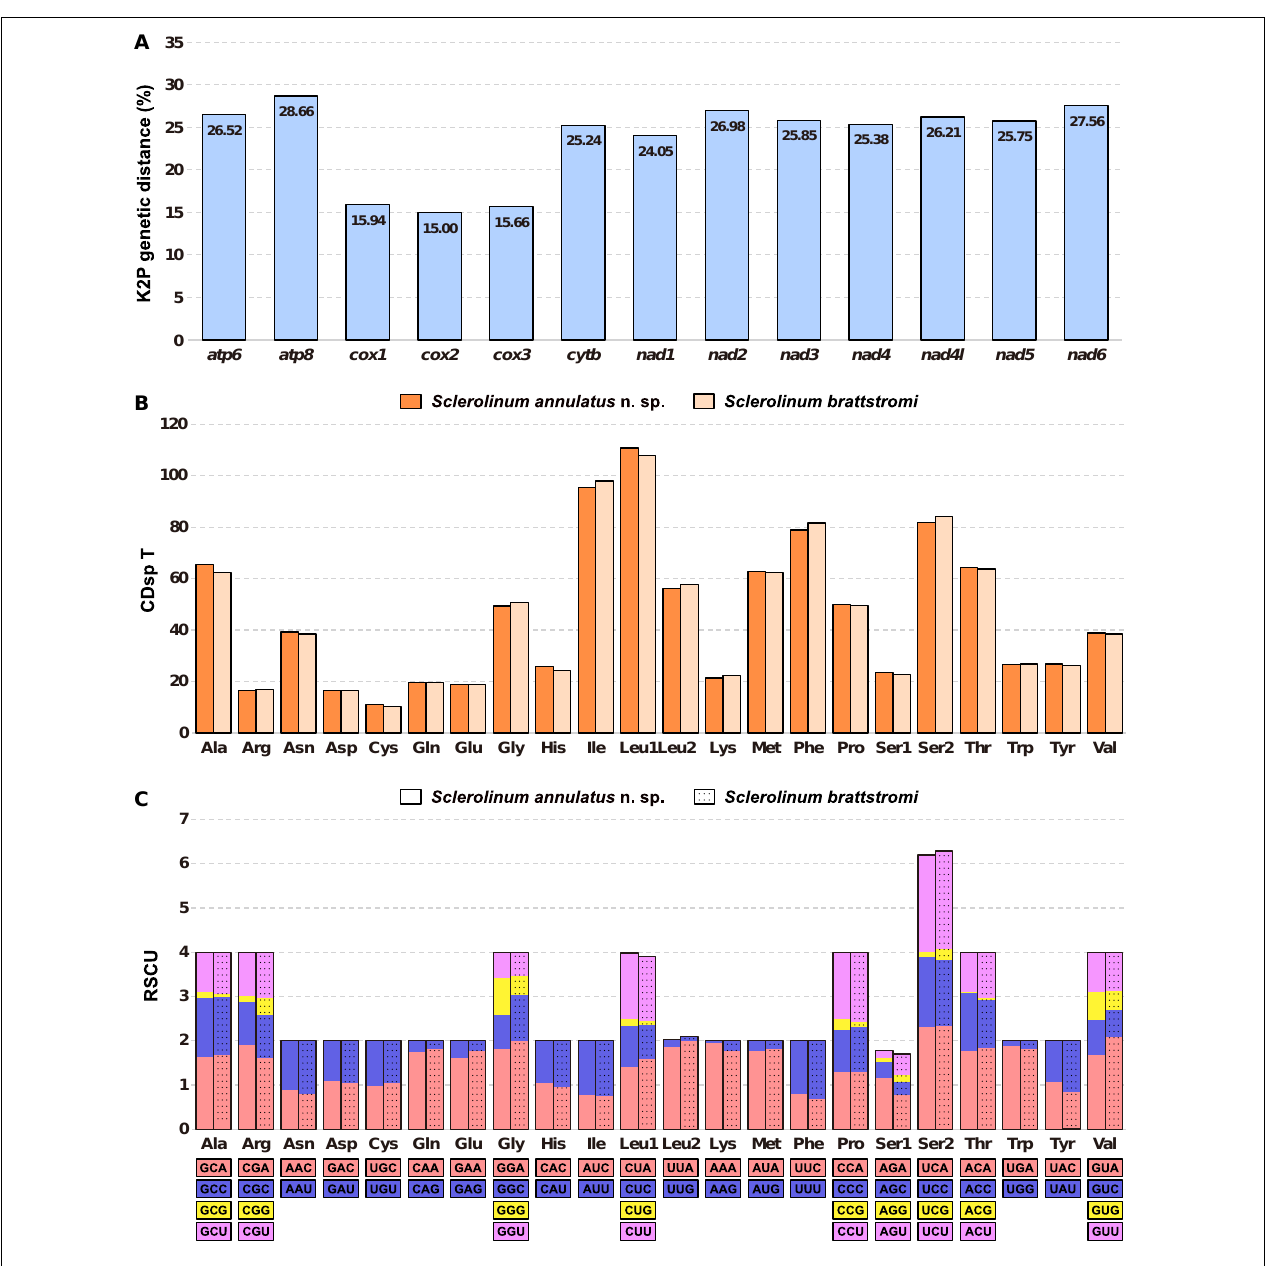
FIGURE 6 | Comparison of the Sclerolinum annulatus n. sp. and Sclerolinum brattstromi mitogenomes. (A) The Kimura-2-parameter (K2P) genetic distance (%) of each mitochondrial protein-coding gene (PCG) between the two species. (B) Codon usage patterns indicated by codons per thousand codons (CDsp T) and (C) relative synonymous codon usage (RSCU) patterns of 13 mitochondrial